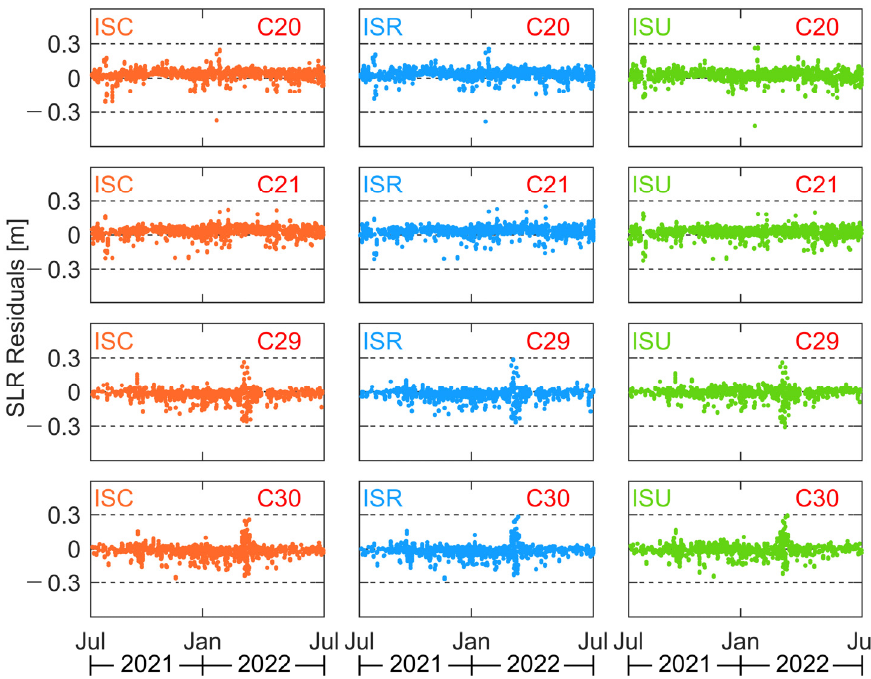
Figure 13. SLR residuals of BDS-3 satellites based on three types of iGMAS B1I/B3I orbits.